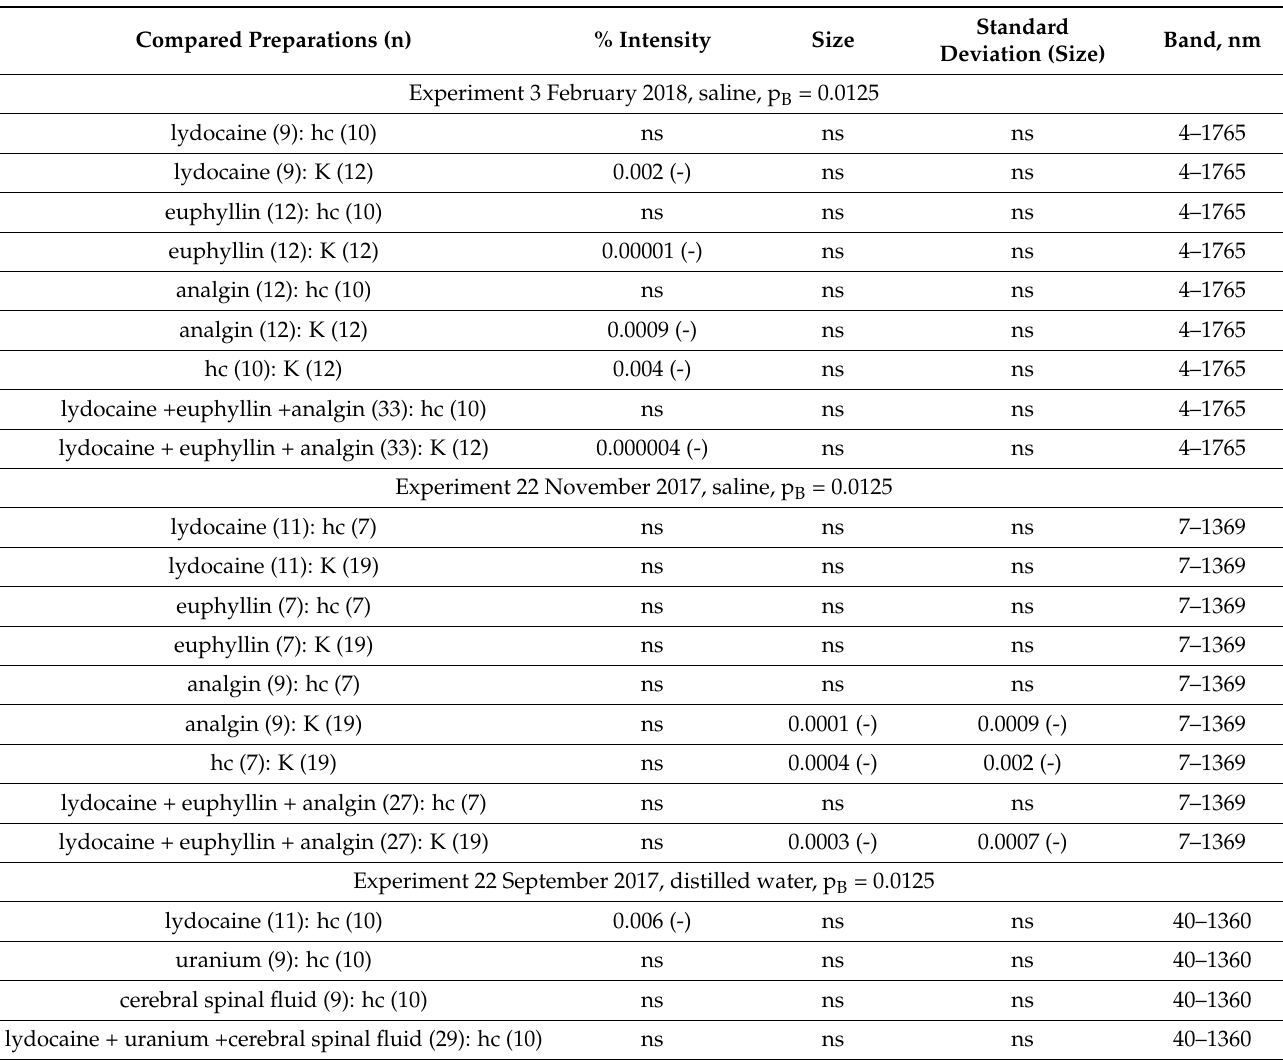
Table 3. Significance p cum (direction) of the differences in ensembles of homeopathic-like preparations and hidden control “hc”/apparent “K” control by spectral parameters of dynamic light